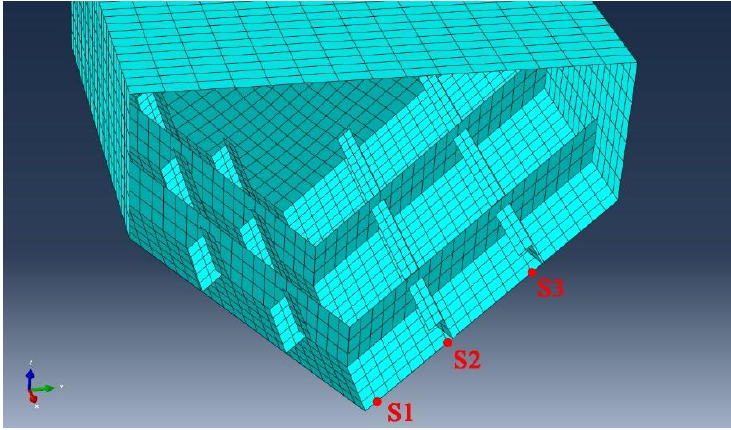
Figure 9. Stress and acceleration monitoring positions on the FE model.